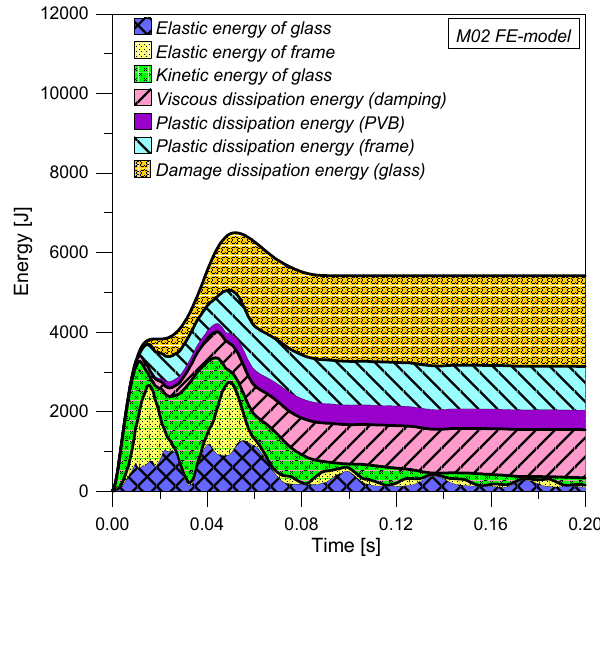
Figure 18. Energy balance for the curtain wall not equipped with VE